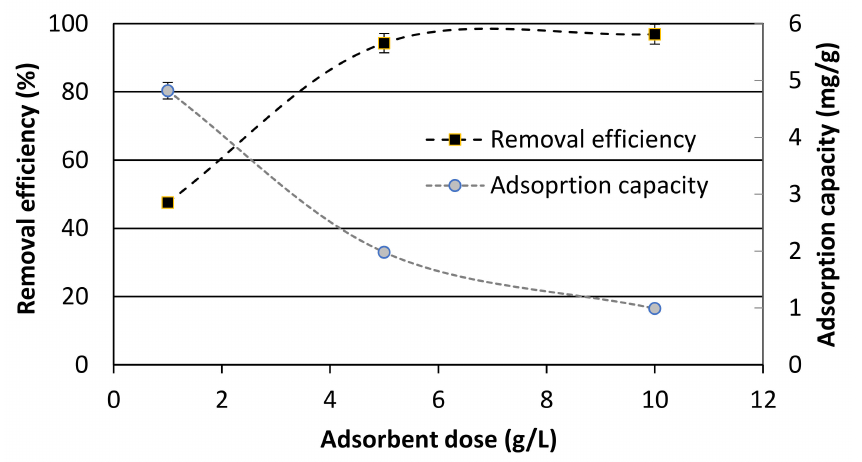
Figure 2. Adsorption capacity and % removal efficiency of TiO 2 as a function of adsorbent dose (C 0 = 10 mg/L, contact time = 7 h, measured pH = 5.0). The error bars indicate the standard deviation of the analytical